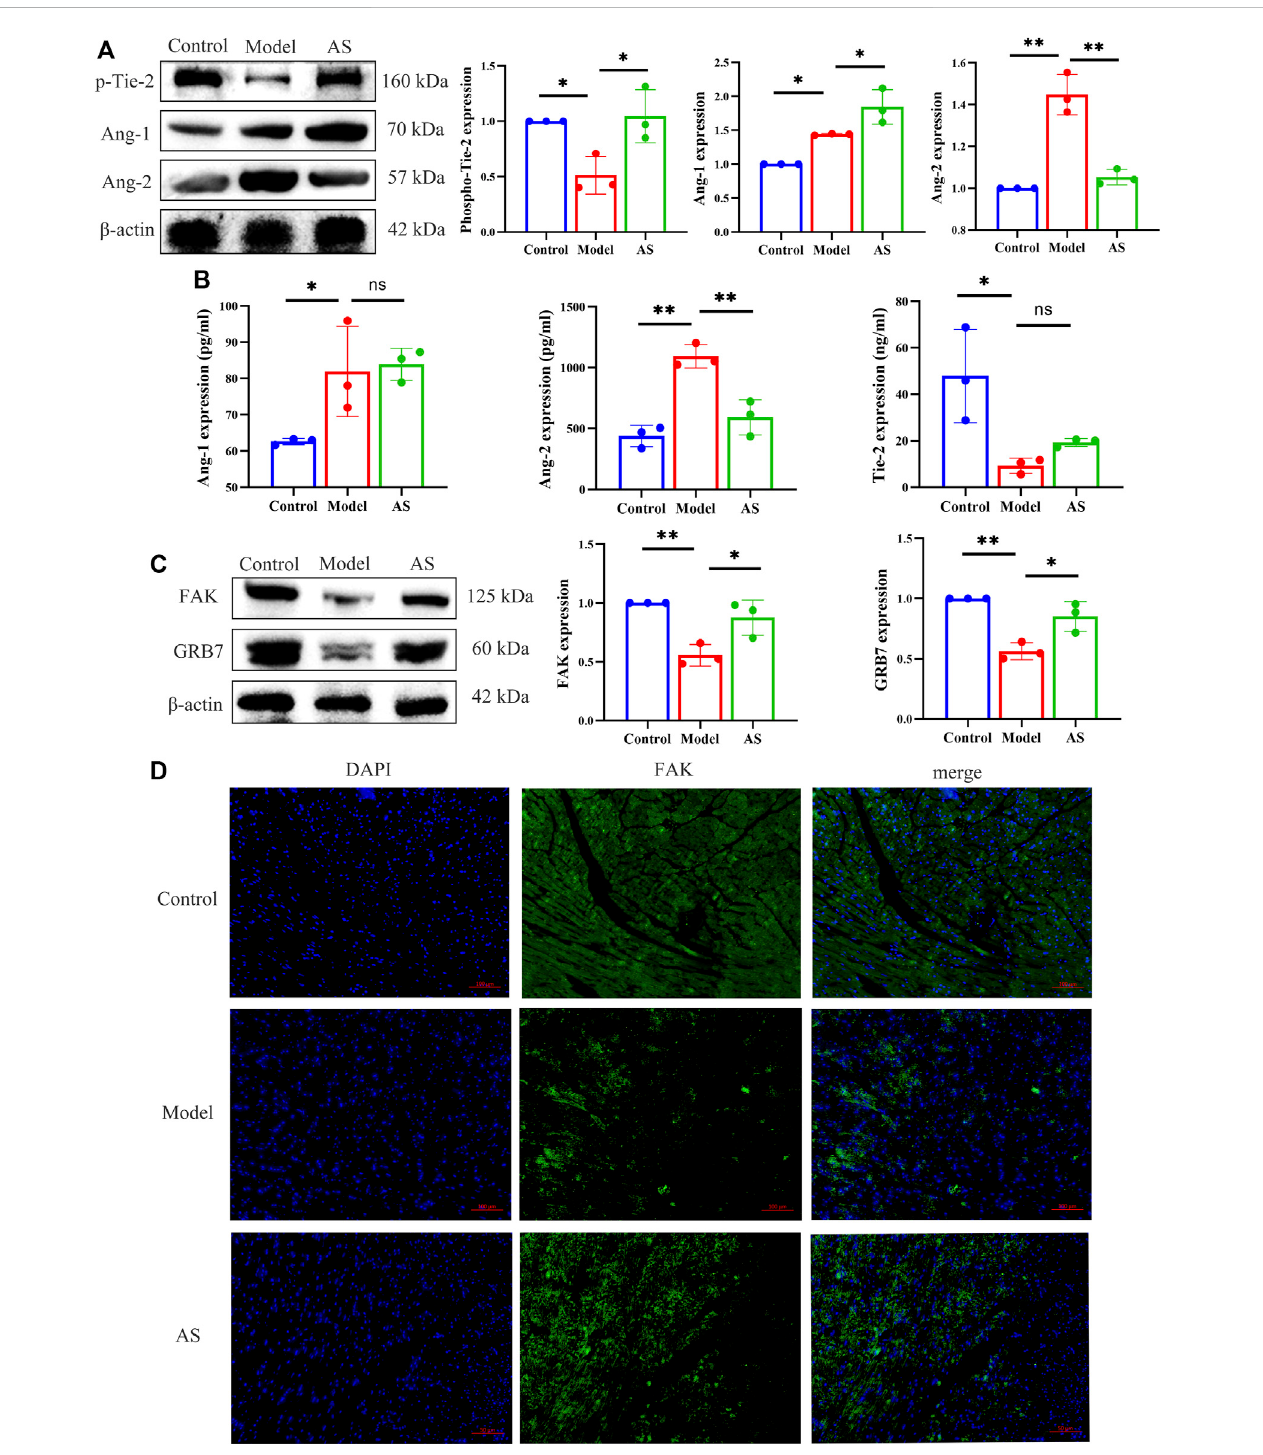
FIGURE 4 AS regulates Ang-1/Tie-2/FAk pathway. (A) Protein level of p-Tie-2, Ang-1 and Ang-2, results are expressed as mean ± SD, n = 3, ** p < .01, * p < .05. (B) Quantitative analysis of Ang-1, Ang-2 and p-Tie-2 concentration, n = 3. Results are expressed as mean ± SD, ** p < .001, * p < .05, ns indicates not signi fi cant. (C) Proteinlevel ofFAK andGRB7,resultsareexpressedas mean± SD,n=3,** p < .01,* p < .05. (D) IFstaining,thegreenregionisFAK,results areexpressedas mean ± SD, n = 3, ** p < .01, * p <